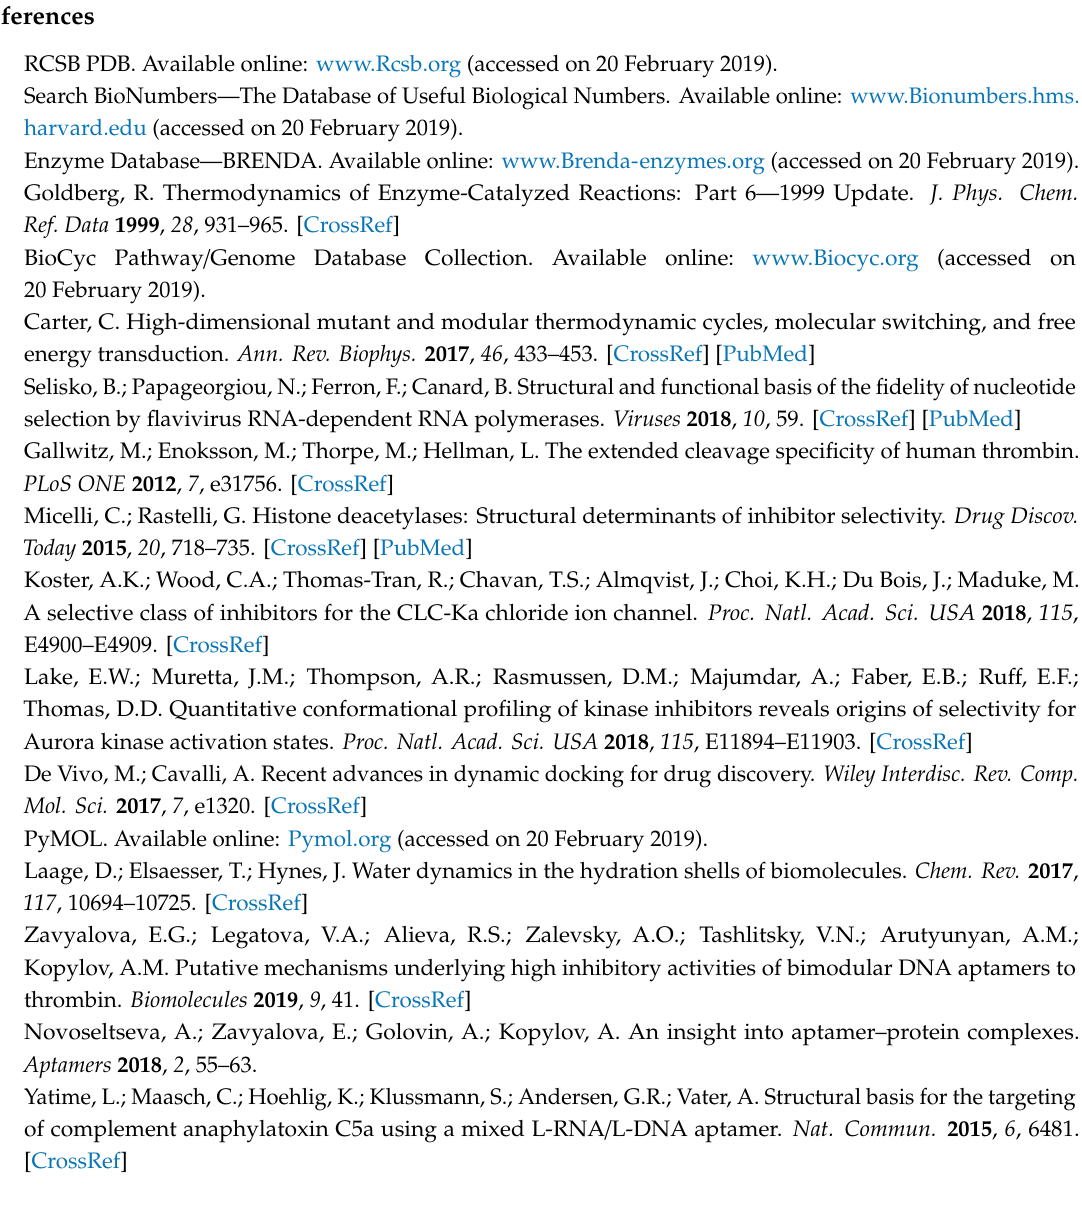
Supplementary Materials: The following are available online. Table S1: Interfaces of aptamer–proteins complexes. Table S2: Parameters for the set of aptamer–protein complexes that were used to find correlations. Table S3: Parameters for the set of aptamer–protein complexes that were used to find correlations (continued). Table S4: Interfaces of HTH-type proteins complexed with DNA duplexes. Table S5: Parameters for HTH-type proteins complexed with DNA duplexes that were used to find correlations. Figure S1: Thrombin complexes with DNA aptamers. Figure S2: PDGFB complexes with modified DNA aptamers SL4 and SL5. Author Contributions: Conceptualization, E.Z. and A.K.; formal analysis, E.Z.; investigation, E.Z.; writing— original draft preparation, E.Z.; writing—review and editing, A.K.; project administration, E.Z. and A.K.;